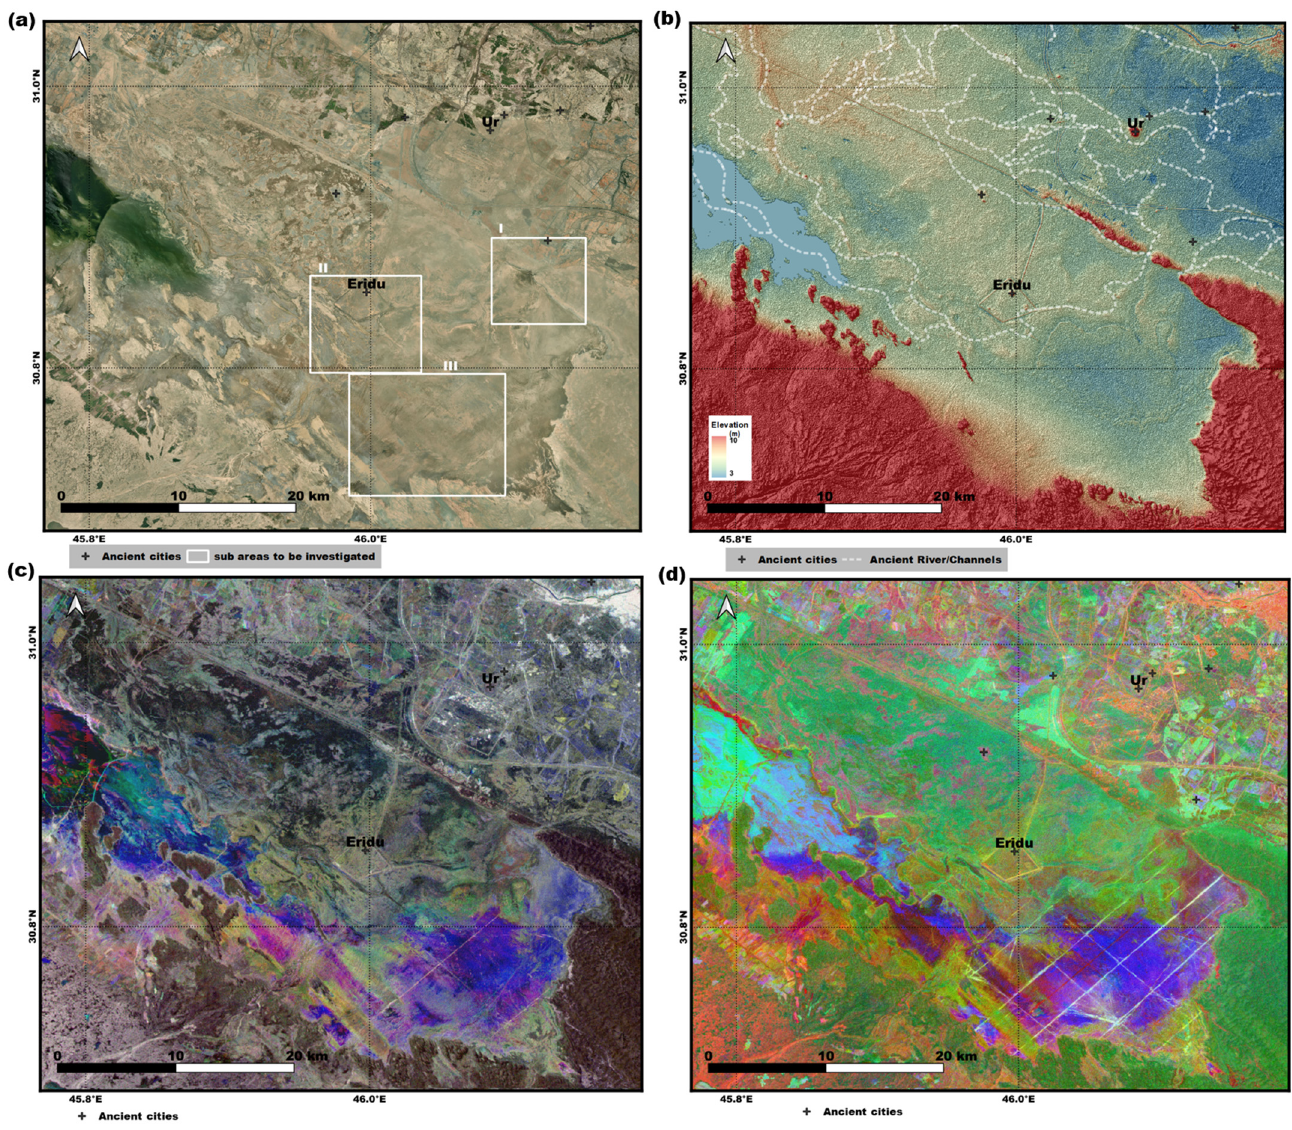
Figure 6. PALSAR-2 products in the Eridu area are assigned as ROI-3. ( a ) Corresponding optical image in Google Earth. Subareas I through III are interpreted in the following section. ( b ) Copernicus 30 m DEM overlaid with paleo-channels. ( c ) PALSAR-2 HH TS Comp. in 2018. ( d ) HH TS Tr-SVD.